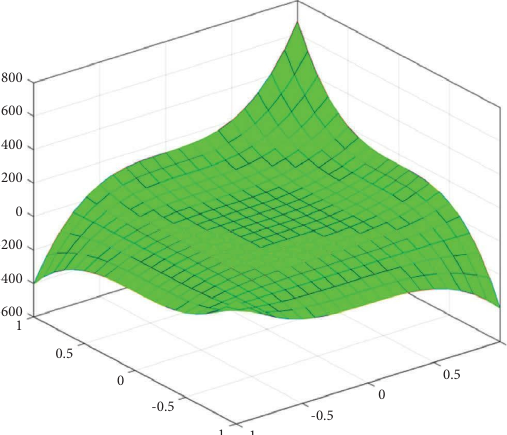
Figure 3: Te correlation of r and M